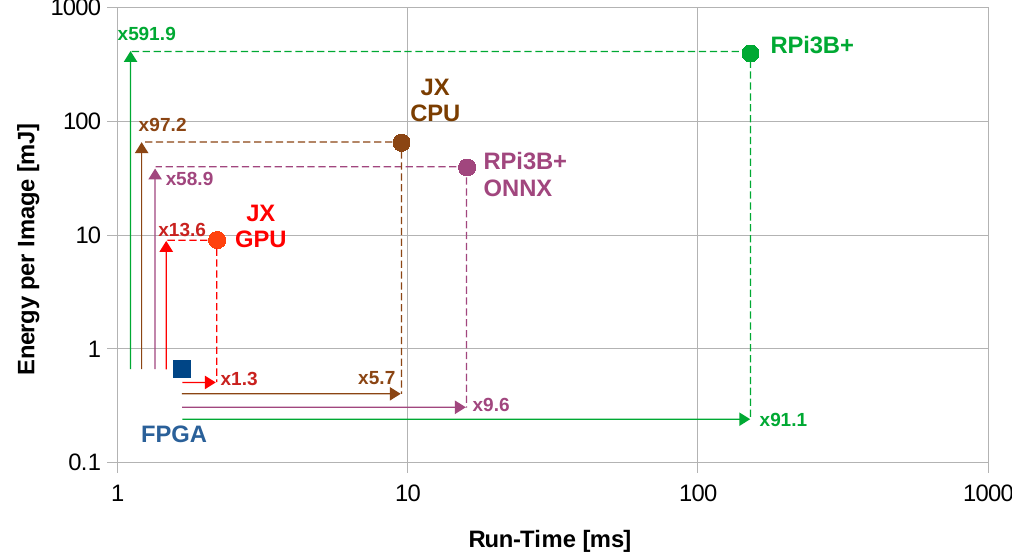
Figure 10. Performance analysis for different embedded platforms; FPGA, JX GPU, JX CPU, RPI3B+ and RPi3B+ ONNX denote the performance of our Xilinx UltraScale+ FPGA, Jetson Xavier embedded GPU, Jetson Xavier embedded CPU, Raspberry Pi 3B+ simple CPU and Raspberry Pi